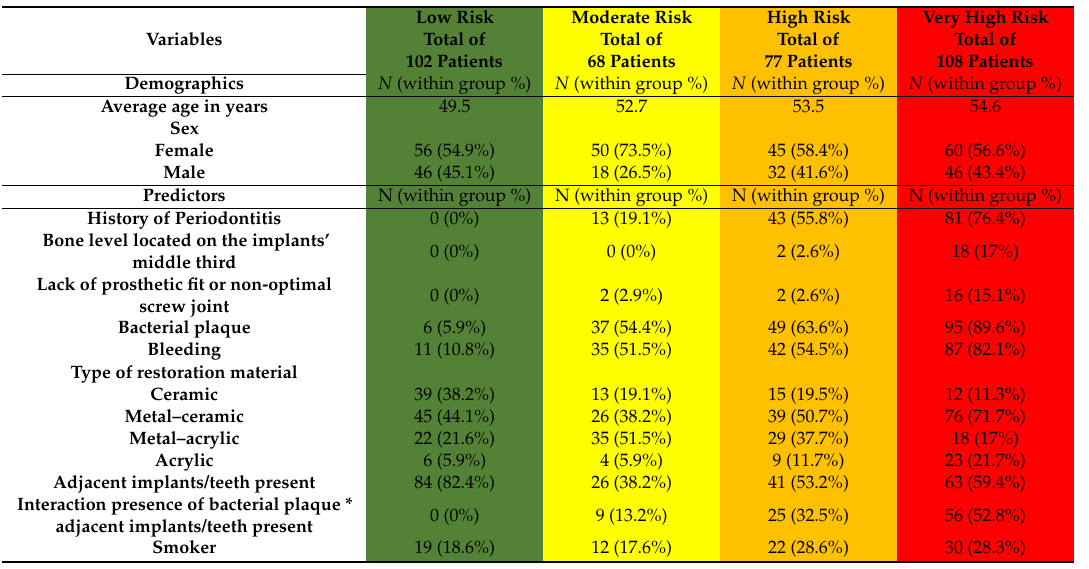
Table 2. Distribution of demographics and predictors according to the risk